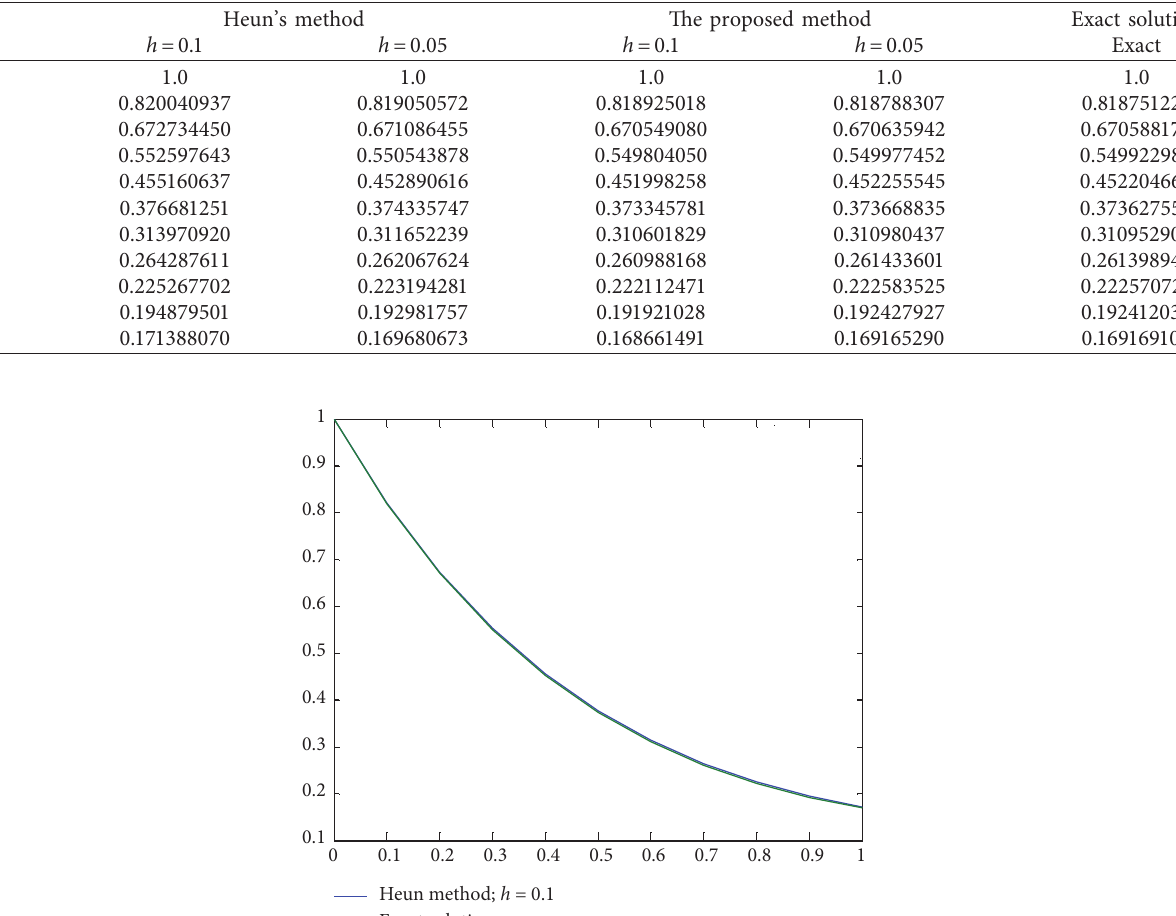
Table 1: Numerical solutions and exact solution for Example